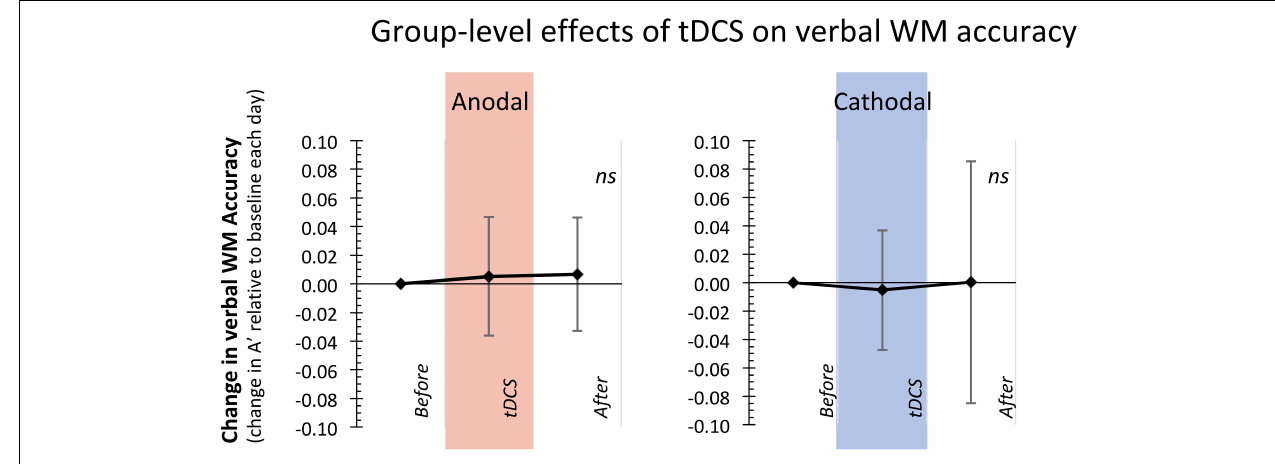
FIGURE 2 | Group-level analyses showed that anodal and cathodal prefrontal tDCS stimulation did not consistently affect WM performance. Displayed here is the change in Accuracy (A (cid:48) ) for the blocks of the task during and after tDCS stimulation relative to the baseline block of that day (error bars represent Standard Deviations from the mean).